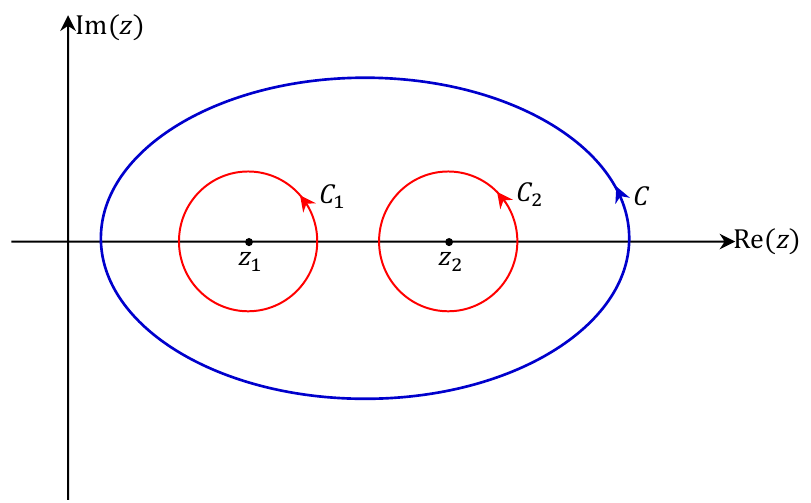
Figure 1 . A schematic diagram showing the contour integral of a function which is analytic except at finite isolated singular points z i along paths C and C i